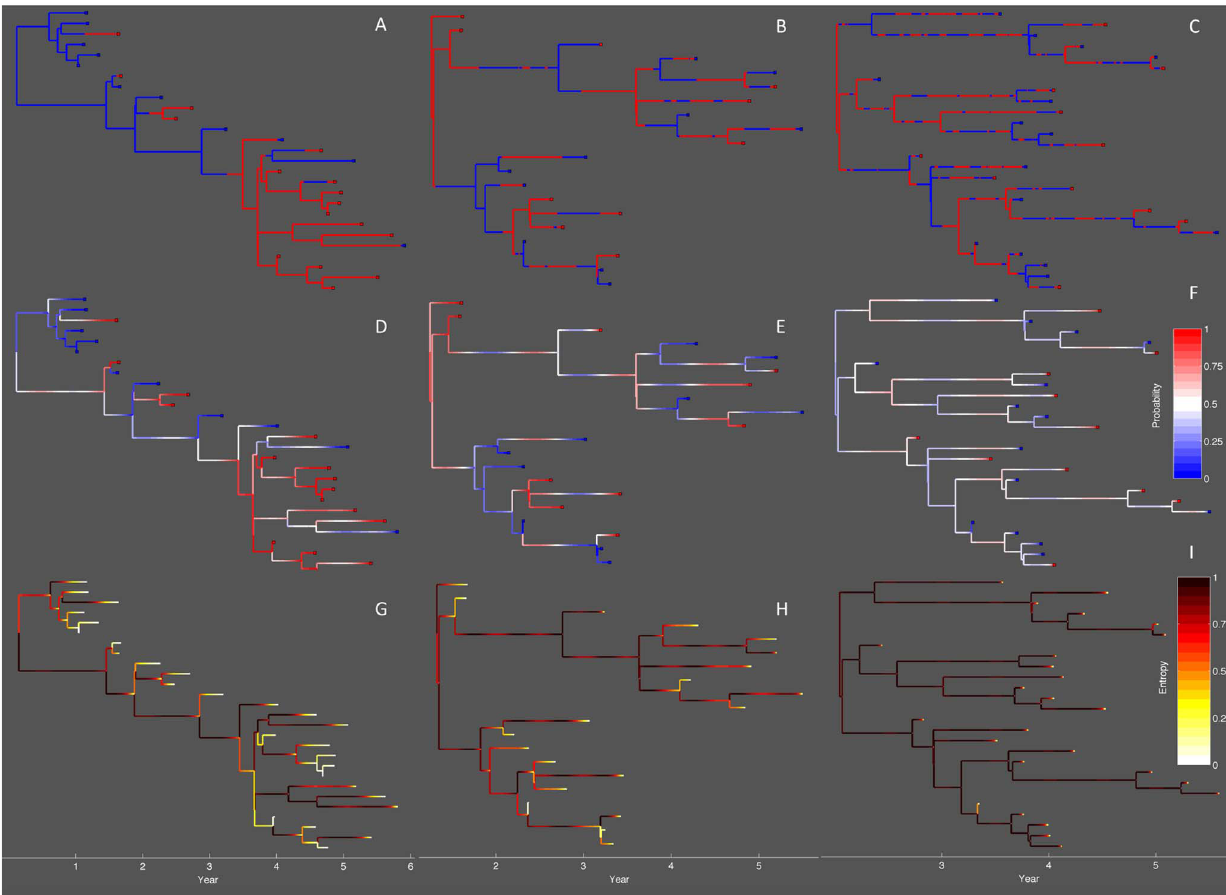
Figure 5. Genealogies simulated under different mixing rates. Mixing rates between the red and blue population were varied from low ( r ~ 0 : 01 ), medium ( r ~ 0 : 05 ) to high ( r ~ 0 : 2 ). (A–C) The true lineage states mapped onto the genealogy. (D–F) Lineage state probabilities given with respect to the probability that the lineage is in the red state. (G–I) Entropy in the lineage states, which shows how much uncertainty there is in the lineage states. For each lineage i , the entropy H i ~{